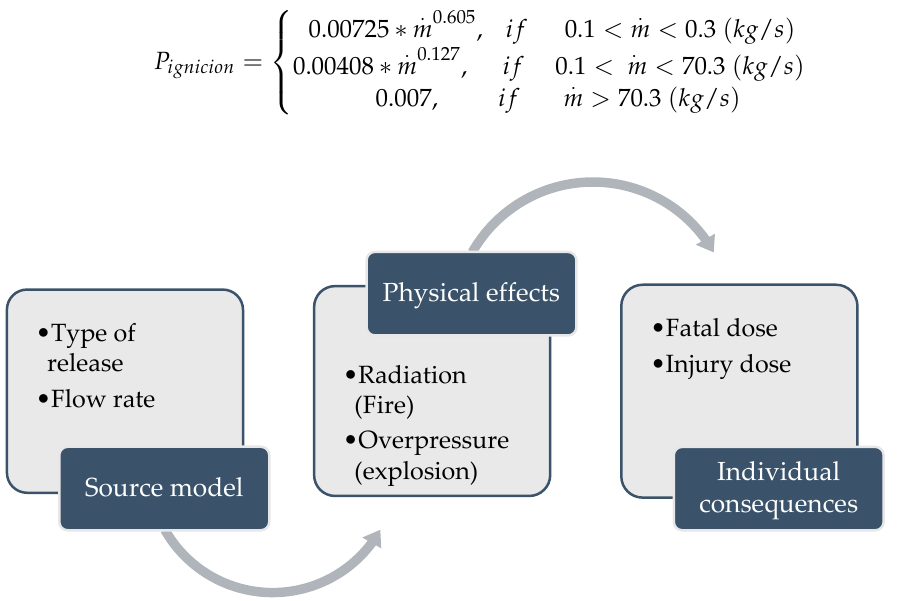
Figure 2. Stages of consequence analysis.